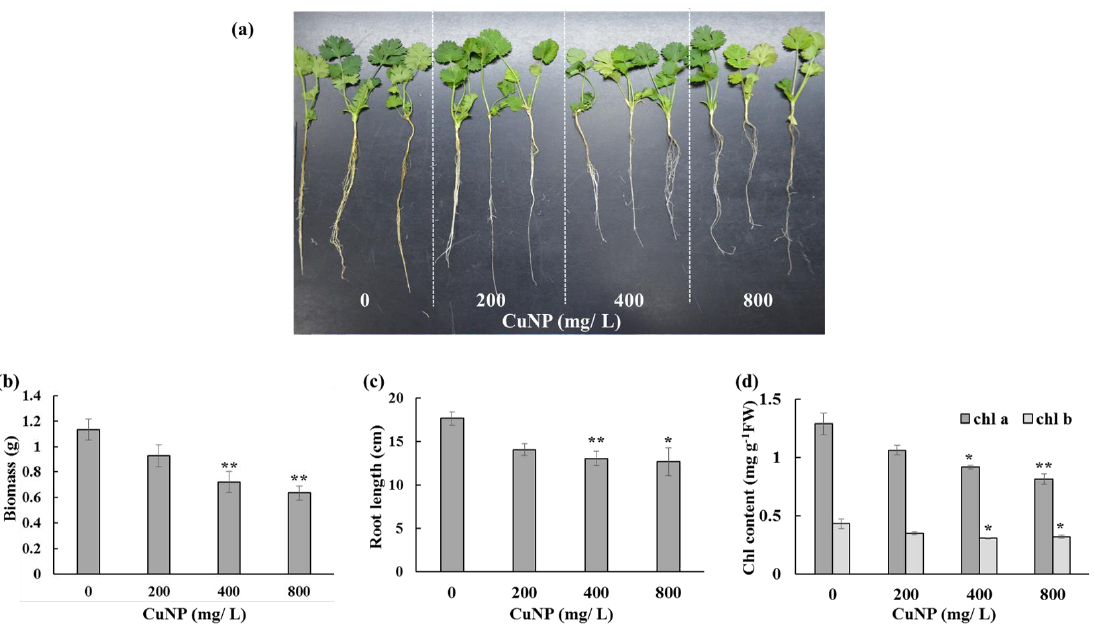
Figure 1. Phenotypic and chlorophyll analysis of C. sativum plants after 7 days of exposure to 200, 400 and 800 mg/L of CuNPs. ( a ) Morphology of roots and shoots of C. sativum control and treated plants. ( b ) Biomass of C. sativum plants. ( c ) Root length of C. sativum plants. ( d ) Chlorophyll a and b contents of C. sativum plants. The values are mean ± se ( n = 3). Statistically significant difference was calculated at * p ≤ 0.05, ** p ≤ 0.01.